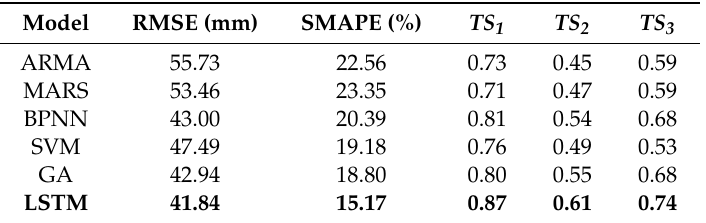
Table 8. Three-hour prediction performance based on the best LSTM model and five other